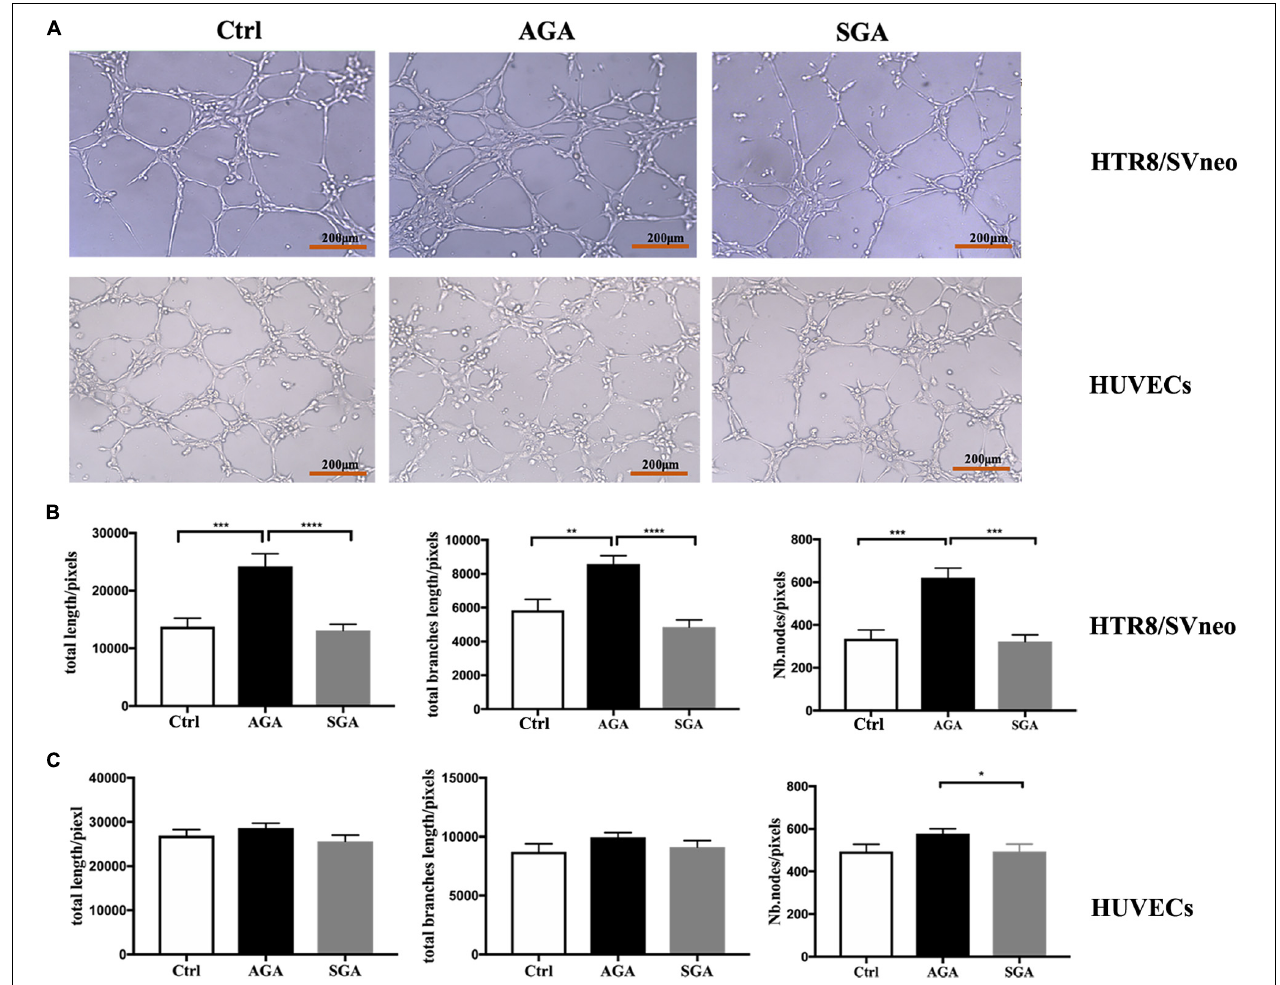
FIGURE 7 | dNK cells in the SGA group exhibited reduced tube formation in trophoblasts. (A) Network-like structures formed by HTR8/SVneo cells and HUVECs in the condition of complete medium (Ctrl), pre-treated with dNK from AGA (AGA) or SGA (SGA). Scale bars represent 200 µ m. (B) The total length, total branches length, and the number of nodes of HTR8/SVneo cells were calculated by ImageJ. (C) Total length, total branches length, and Nb. nodes of HUVECs were calculated by ImageJ. Statistical analysis was based on the results of six independently repeated experiments. ** p < 0.005, *** p < 0.0005, **** p <